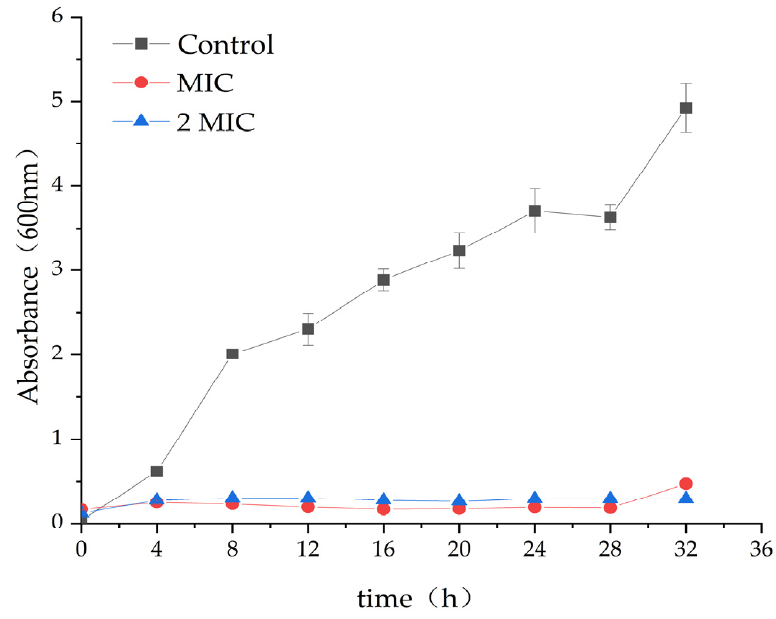
Figure 1. Effect of MA on the growth curve of S. aureus.